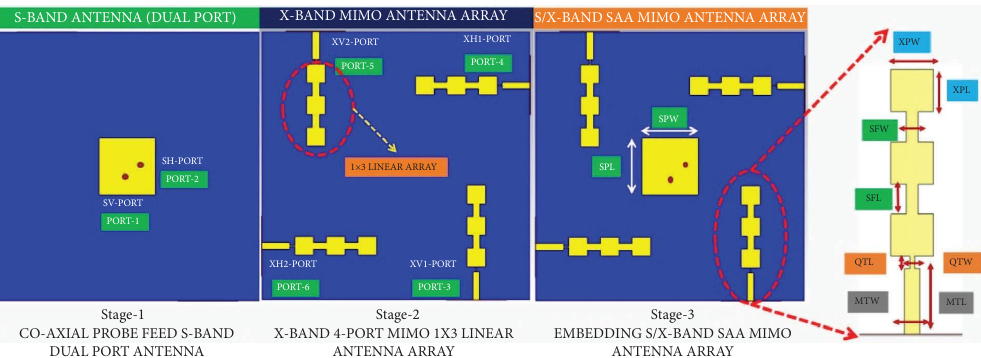
Figure 7: S/X-SAA geometry of evolution